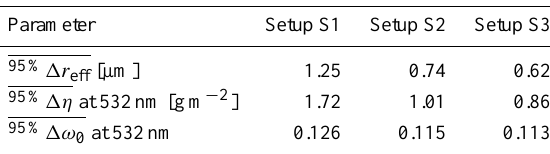
Table 4. Widths of the 95% confidence intervals of the effective radius, 95% (cid:49)r eff , the mass-extinction conversion factor, 95% (cid:49)η , and the single scattering albedo, 95% (cid:49)ω 0 , averaged over 100 input ensembles (see Sect. 4 for